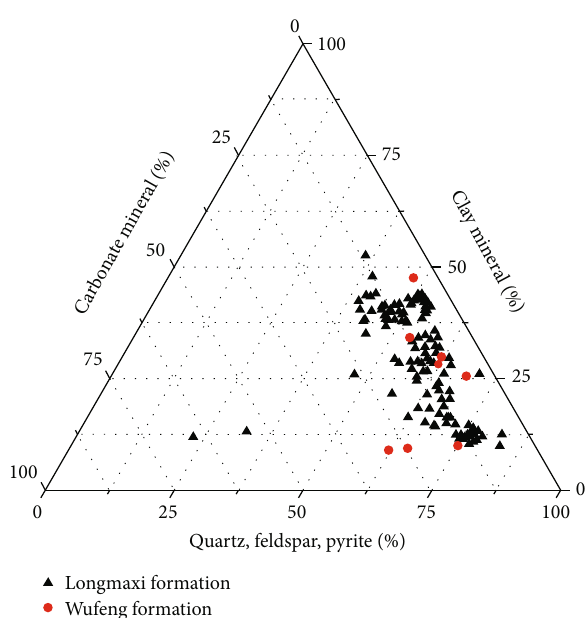
Figure 5: Ternary diagram of mineral